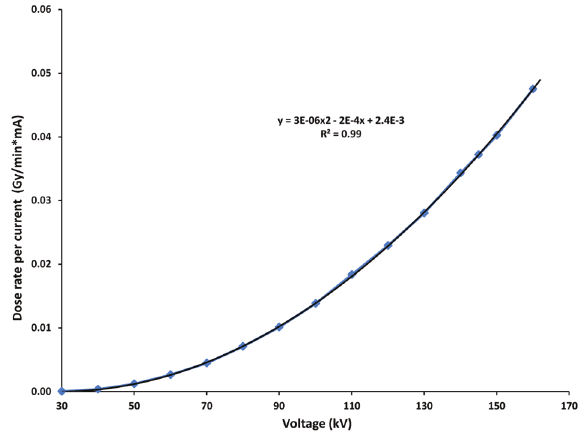
Figure 7. Relationship between dose rate and tube voltage (default position).